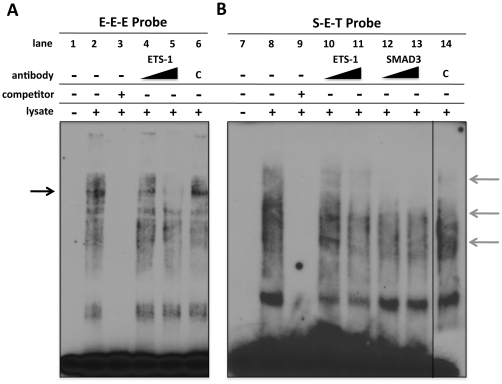
Ets-1 binds to EBE sites in the CCN2 promoter in osteoblasts.Electro-mobility shift assays (EMSA) from nuclear lysates were generated from osteoblasts that were treated with TGF-β1 (5 ng/ml) for 2 hrs. (A) Nuclear protein binding to the wild type E-E-E (lanes 1–6) (this probe contains EBE # 6-8; for probe design see Figure 6) probe was assessed using 5 µg of nuclear lysates for each reaction. In some reactions, Ets-1 antibody was added at increasing concentrations (1 ug of antibody in lane 4; Two micrograms of antibody in lane 5) to test for Ets-1/probe interaction. Control antibody (2 ug) was also used (lane 6; C). In some cases, probe only (lane 1) or a molar excess of unlabeled probe (lane 3) was also used to demonstrate specificity. (B) Nuclear protein binding to the wild type S-E-T (lanes 7–14) (this probe contains EBE#5; for probe design see Figure 6) probe was assessed using 5 µg of nuclear lysates for each reaction. In some reactions, Ets-1 antibody was added at increasing concentrations (1 ug of antibody in lane 10; 2 ug of antibody in lane 11) to test for Ets-1 protein/probe interaction or Smad 3 antibody (1 ug of antibody in lane 12; 2 ug of antibody in lane 13) to test for Smad 3 protein/probe interaction. Control antibody (2 ug) was also used (lane 14). In some cases, probe only (lane 7) or a molar excess of unlabeled probe (lane 9) was also used to demonstrate specificity.